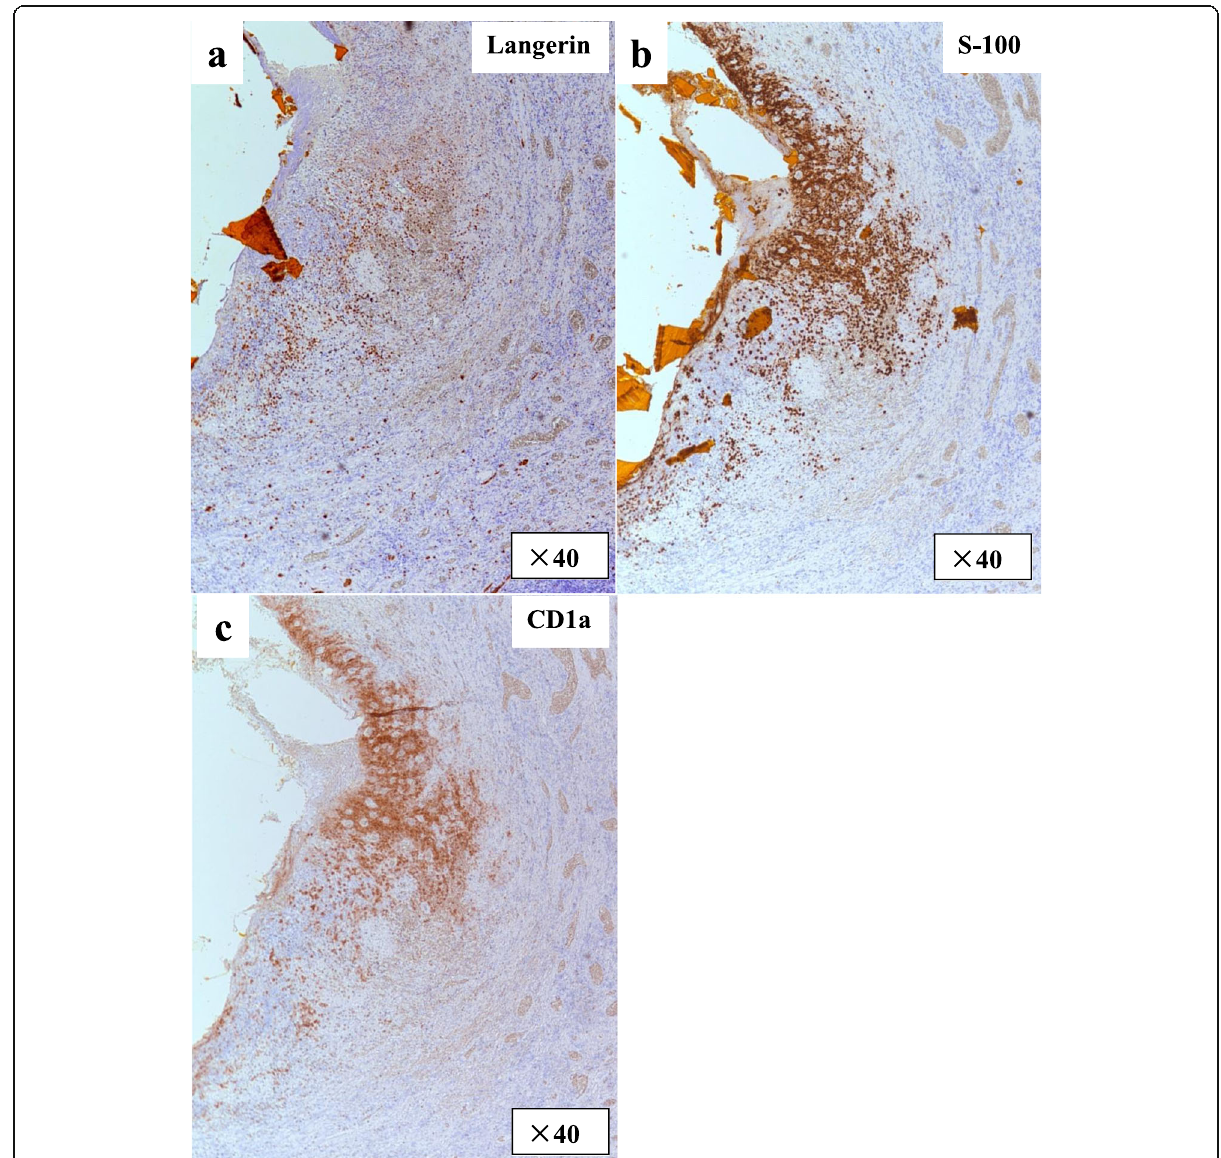
Fig. 4 Immunohistochemical staining of the common bile duct. a Immunohistochemical staining of Langerin. b Immunohistochemical staining of S-100 protein. c Immunohistochemical staining of